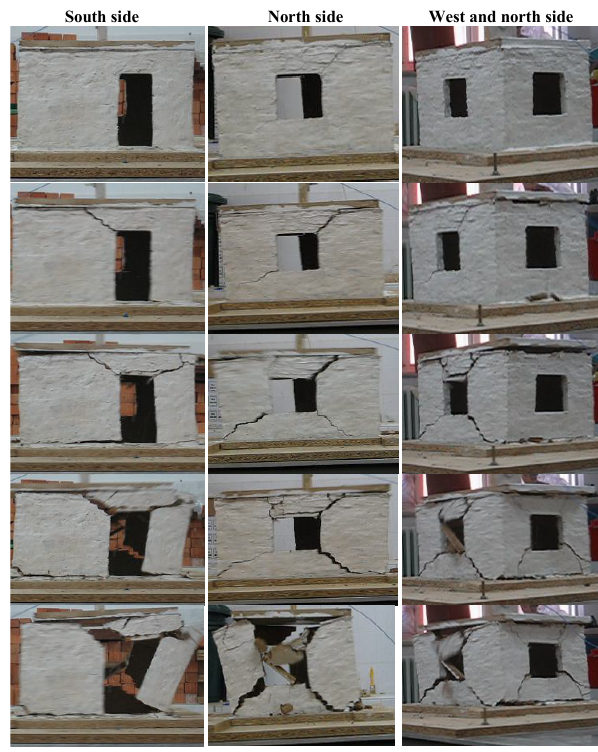
Fig. 8. Failure sequence of specimen Ref.